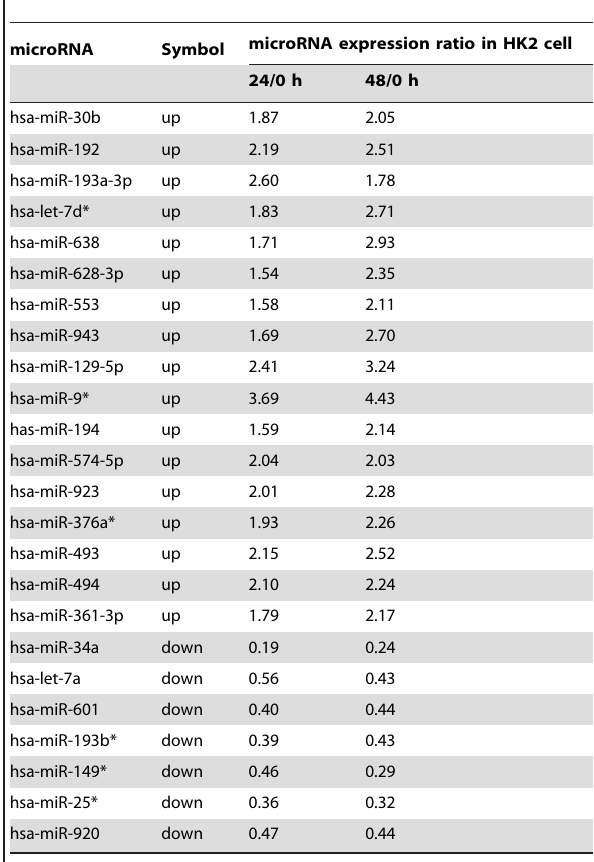
Table 2. Summary of hypoxia-regulated microRNAs in HK2